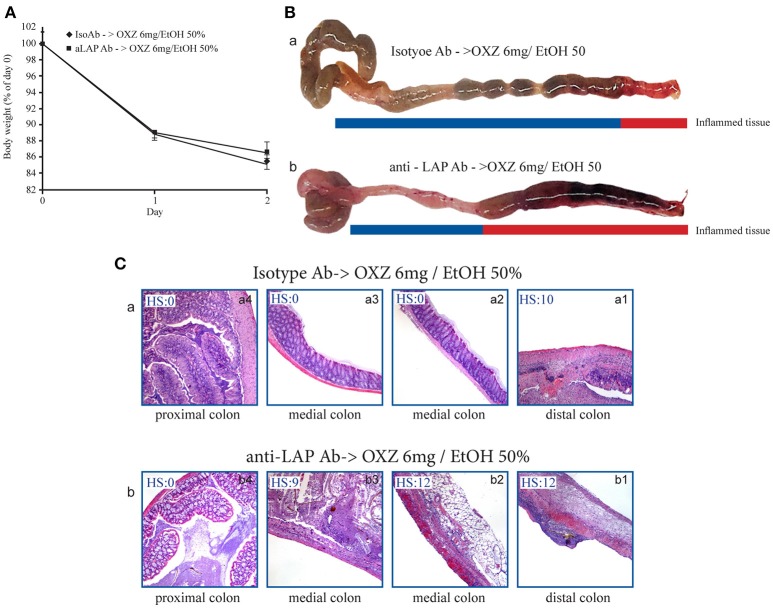
Depletion of LAP+ cells is associated with proximal extension of inflammatory lesions in the mouse oxazolone-induced colitis model. (A) Weight changes in oxazolone-treated mice (6 mg/ethanol 50%) pretreated with either Isotype Ab or anti-LAP Ab. Each point represents the cumulative mean (± SE) weight from 3 separate experiments in which 5 mice per group were studied. (B) Representative macroscopic images of colons of oxazolone-treated mice pretreated with (a) Isotype Ab or (b) anti-LAP Ab. (C) H&E stained colonic specimens (40 × magnification) of distal, medial and proximal colonic portions of oxazolone-treated mice pretreated with (a) Isotype Ab (a1-a4) or (b) anti-LAP Ab Isotype Ab (b1-b4). HS, histopathologic score (see methods).